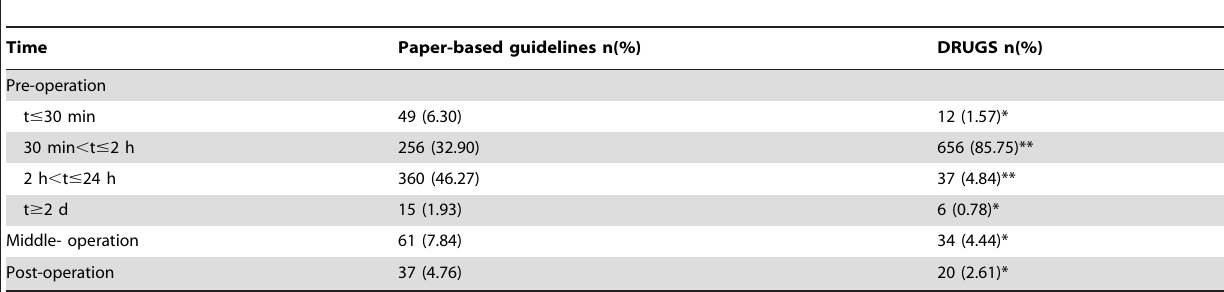
Table 3. Time of the initial dose of antimicrobial agent among pre-and post-intervention.